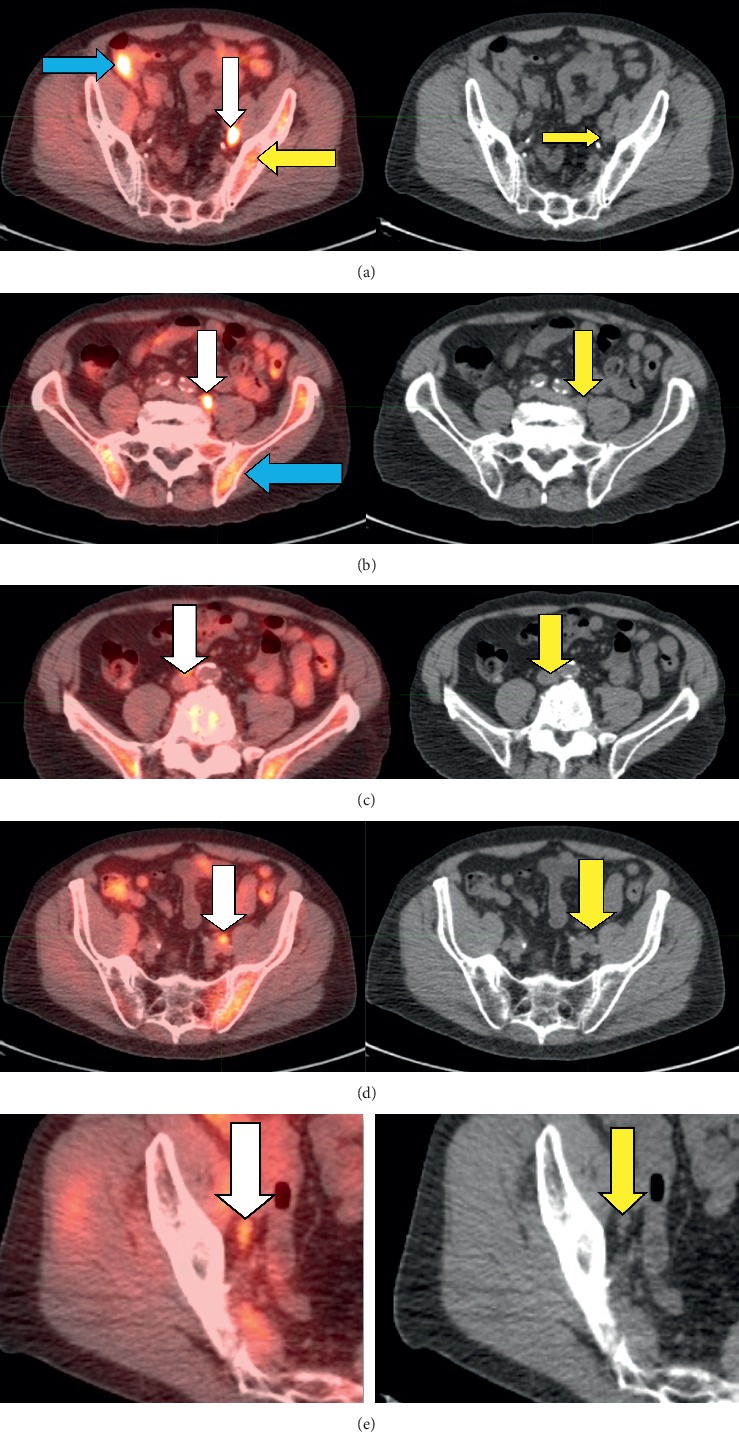
Images of a 68-year-old male who had undergone radiation therapy, followed by short-term androgen deprivation therapy. He was referred for 18F-fluciclovine imaging, on no treatment, when his PSA rose to 10.5 ng/mL. Five rows of images from his study are shown, to demonstrate varying intensities of uptake. SUVs, a semiquantitative measure of uptake intensity, are given, with higher values denoting greater intensity; compare to marrow uptake at the same level (yellow arrows in PET images). First (top) row: the first, left-hand image identifies a 1.4-cm left obturator node (SUV: 7.6) (white arrow). The blue arrow points to physiologic bowel uptake. The yellow arrow points to physiologic uptake in the marrow of the left iliac bone. The image on the right is the corresponding CT view; the yellow arrow points to the left obturator node. Second row down: left-hand image shows metastasis at the level of the common iliac nodes (SUV: 5.8). The blue arrow points to typical, heterogeneous bone marrow uptake (normal). The corresponding CT image on the right shows the node adjacent to the psoas muscle. Third row down: the left-hand image identifies a 1-cm aortocaval metastasis (SUV: 3.2). The yellow arrow on the corresponding CT view points to a lymph node at this site. Fourth row down: the left-hand image identifies a 1-cm left external iliac node (SUV: 3.5). The yellow arrow on the right points to the node on the CT view. Fifth (bottom) row: the left-hand image shows a 6-mm right obturator node (white arrow). Although the SUV is only 2.7, the node still clearly shows enhanced uptake compared to the adjacent iliac marrow. CT image on the right identifies the node (yellow arrow).